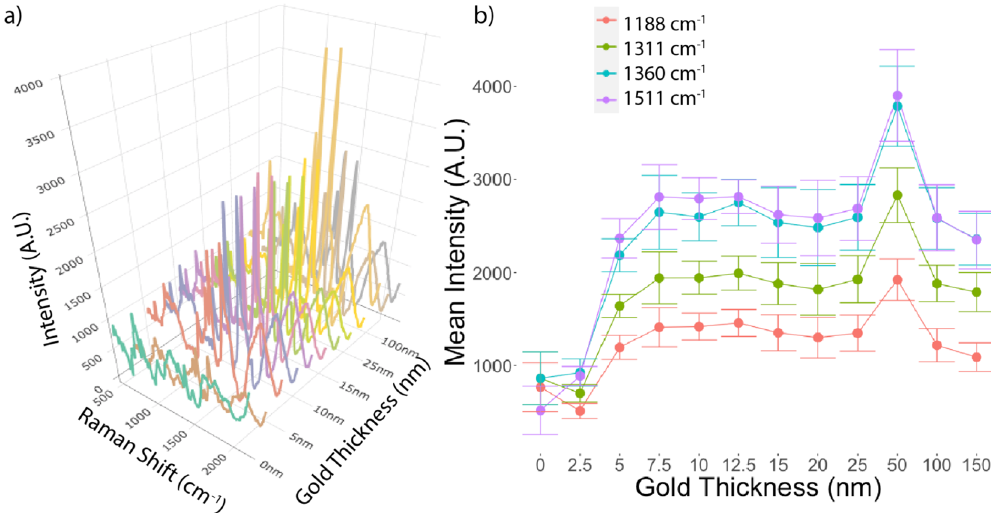
Figure 1. Effect of gold coating thickness on Rhodamine 6G Raman spectra. ( a ) Mean Raman Spectra of Rhodamine 6G on PVDF filters with differing gold coating thicknesses. ( b ) Mean intensity with standard deviation (error bar) of the four most prominent peaks in the Rhodamine 6G spectra (1188, 1311, 1360 and 1511 cm −1 ) for differing gold coating thicknesses. Thickness greater than 2.5 nm provided significant enhancement of all 4 prominent peaks, with the greatest enhancement seen with filters with a 50 nm gold